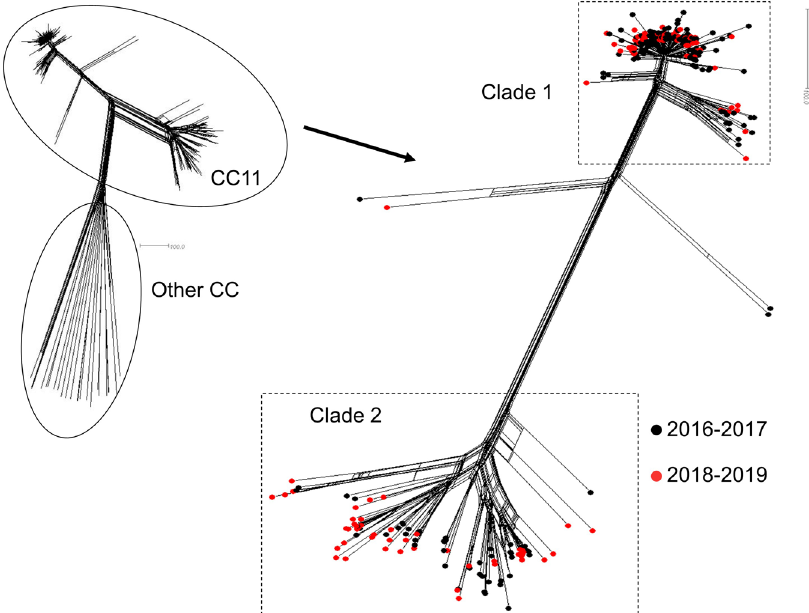
Fig. 5 Neighbour-net phylogenetic network of all IMD culture-con fi rmed cases due to NmC cases in France for the period 2016 – 2019. The major genotype (CC11) is indicated. To the right, the two major Clades (1 and 2) of the CC11 are surrounded by dashed lines. Isolates from the two periods 2016 – 2017 (before the mandatory vaccination) and 2018 – 2019 (after the mandatory vaccination) are indicated in black and red circles respectively.